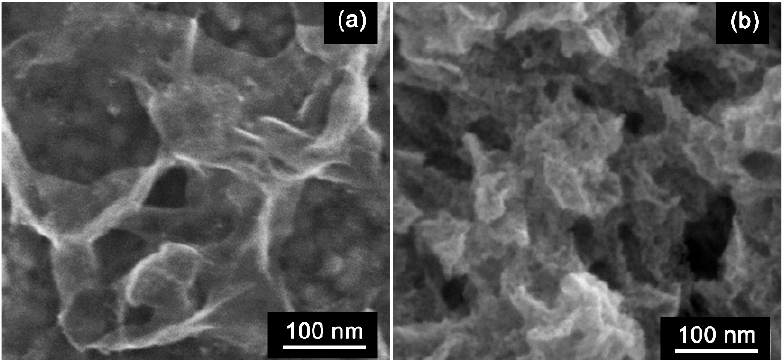
Figure 4. SEM images of SnS 2 nanosheets before ( a ) and after ( b ) oxidation at 500 °C. The X-ray diffraction pattern of the SnS 2 nanosheets (Figure 5) is close to the diffrac- togram of the SnS 2 Berndtite-2T standard (ICDD No. 23-677). The diffraction pattern contains broadened reflections (100) and (110), which refer to the directions lying in the plane of the sheet. At the same time, the reflection (001) corresponding to the normal to the plane of the sheet does not appear. This may be due to the extremely small thickness of the sheet that indicates the implementation of a 2D structure. The oxidation of the SnS 2 nanosheets leads to the formation of SnO 2 with a cassiterite structure (ICDD No. 41-1445). The diffraction maxima of 2D SnO 2 are greatly broadened, which indicates the small size of the crystal grains. The crystallite size of the 2D SnO 2 calculated using Sherrer’s formula with (110) and (101) reflections is 4.0 ± 0.5 nm, which correlates with the high specific area of 44 ± 2 m 2 /g.